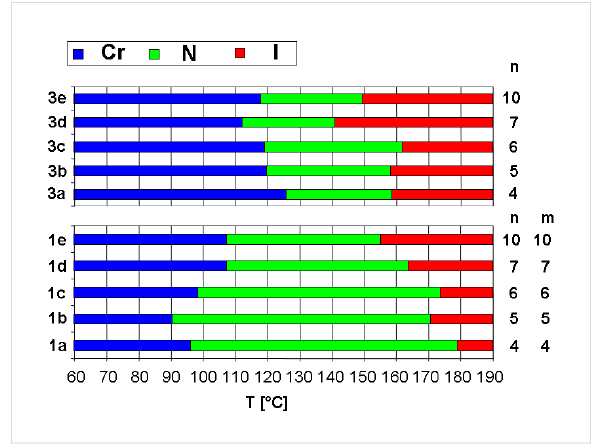
Figure 3: Comparison of the mesophase ranges of intermediate hockey stick compounds 3 and symmetric V-shaped nematogens 1